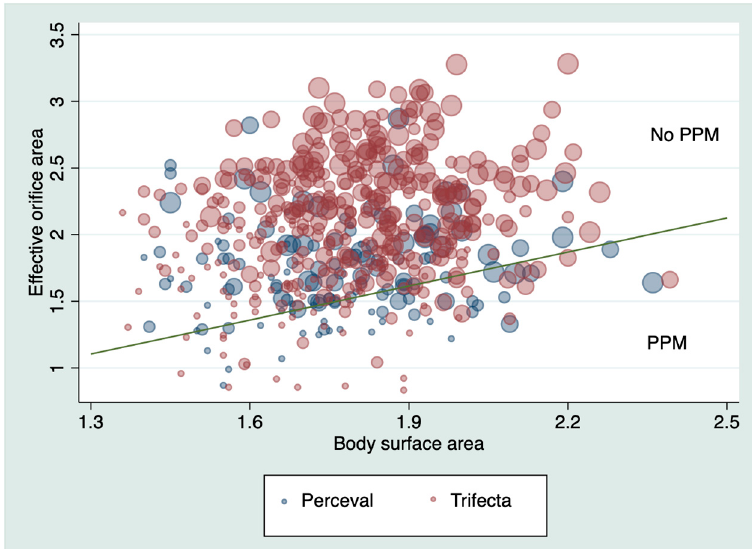
Figure 3. Relationship between effective orifice area and body surface area. Green line separates patients with and without PPM. The sizes of circles vary according to size of the prostheses. (19 Trifecta similar to S Perceval, 21 – M, 23 – L, and 25/27 – XL). PPM: patient – prosthesis mismatch. Compared with the Perceval prosthesis, the Trifecta prosthesis was shown to reduce PPM (all degrees together): OR = 0.5 (95% CI 0.3–0.9, p = 0.04). Figure 4 shows the predicted probability of any degree of PPM based on the type of prosthesis and according to the different BSA for our sample.